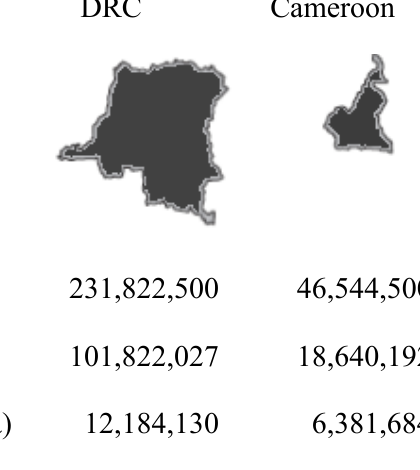
Figure 1. Land and forest areas in DRC and Cameroon Sources: adapted from [10,11].